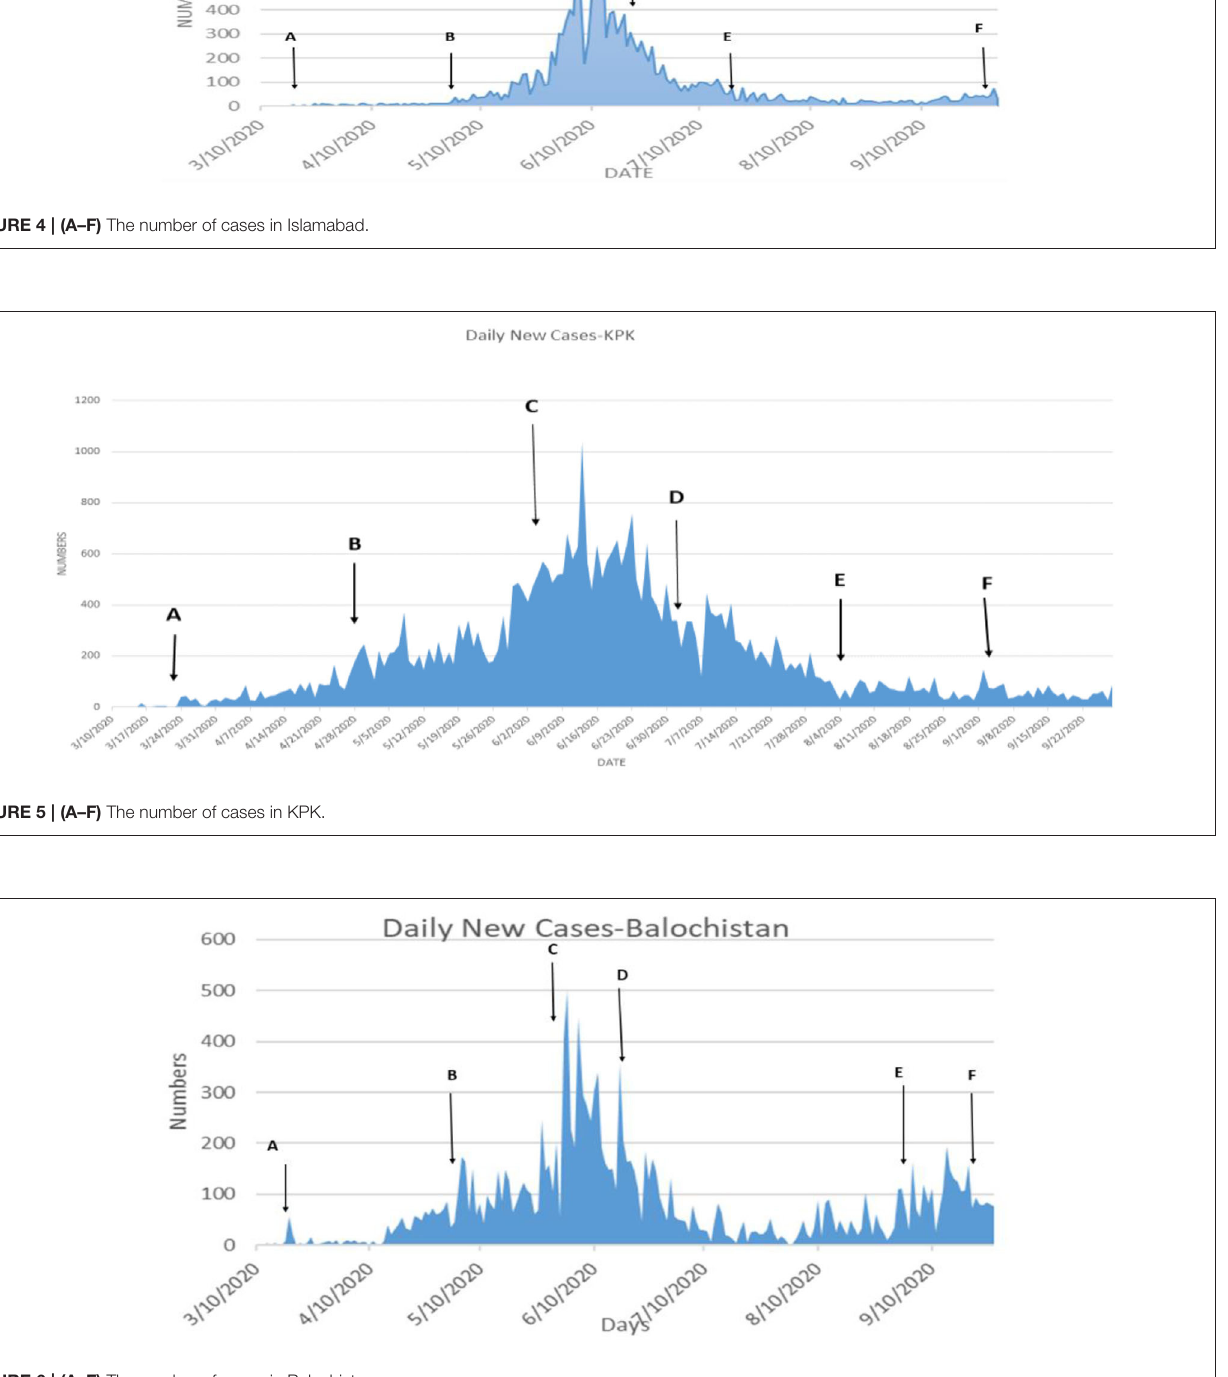
FIGURE 6 | (A–F) The number of cases in